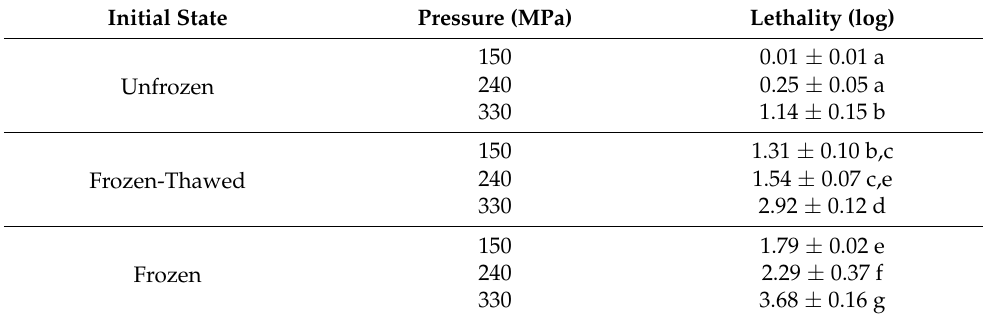
Table 2. Lethal effects of high-pressure treatment on E. coli under three different conditions. Initial